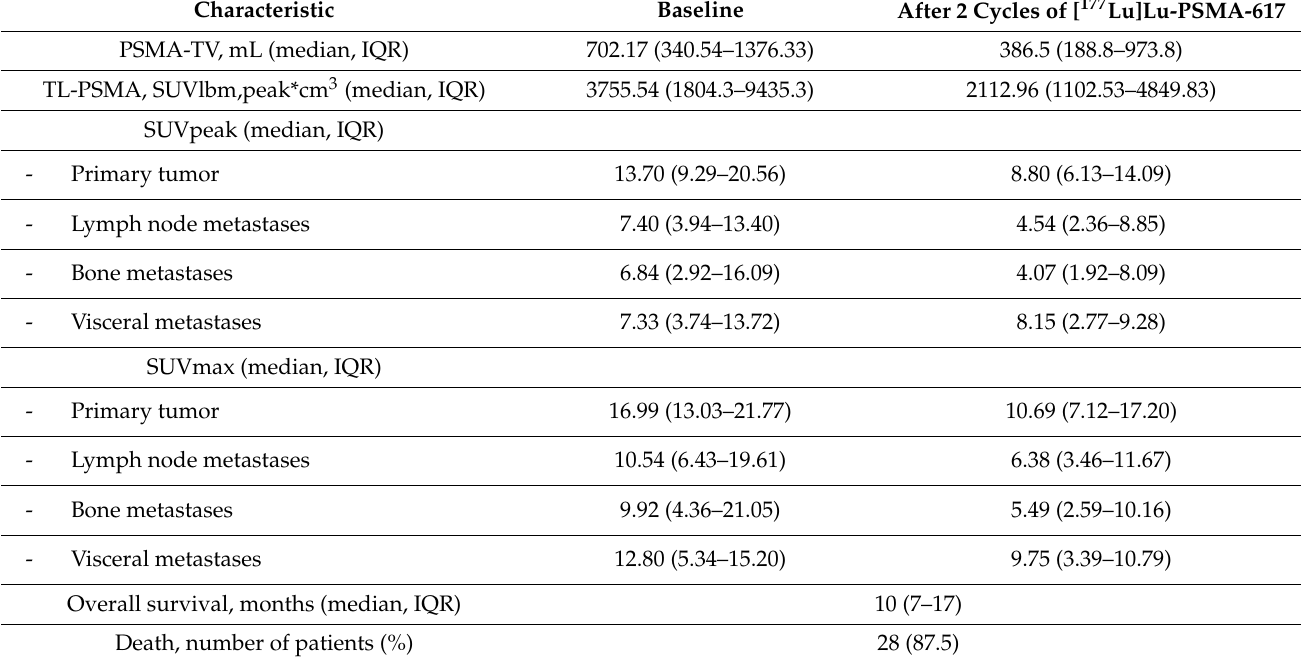
Table 2. Imaging baseline